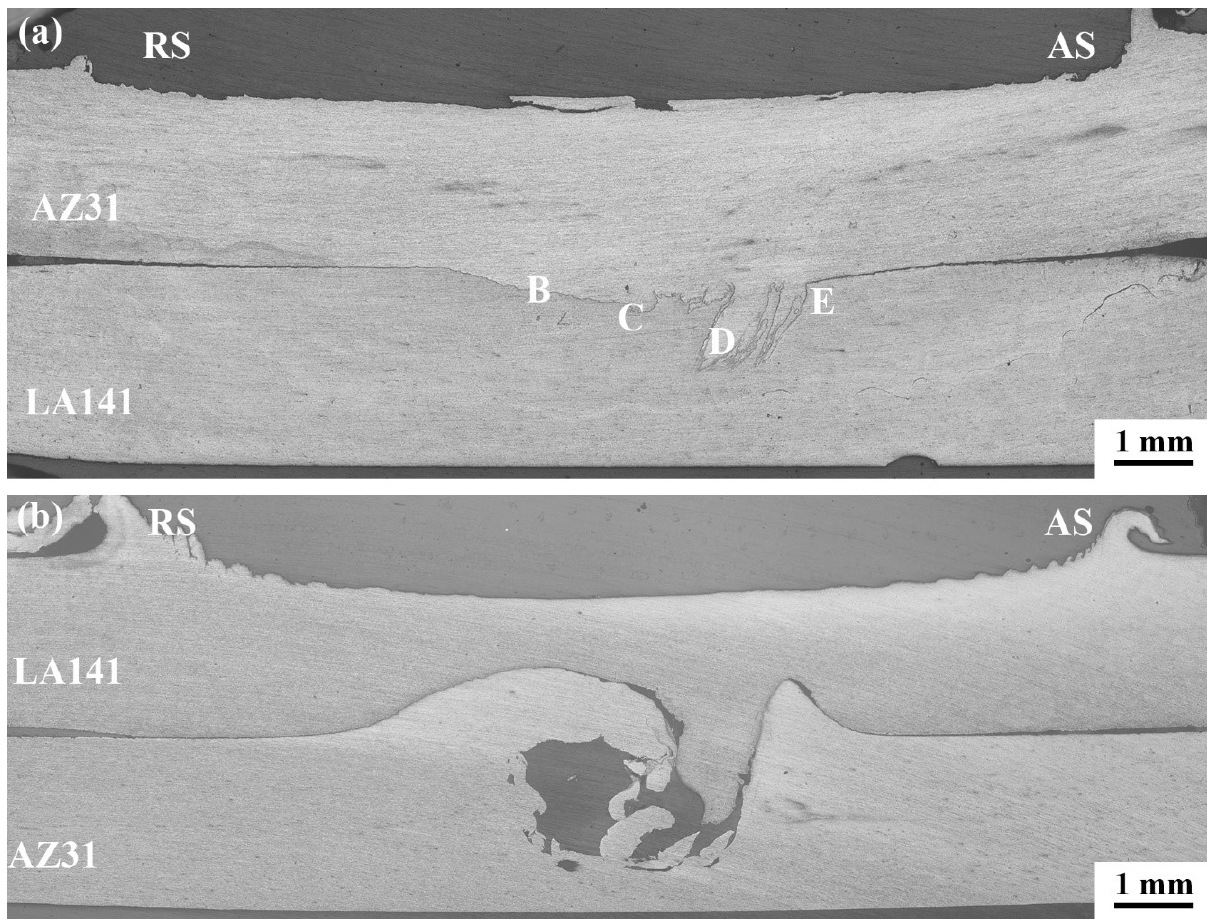
Figure 5: Typical cross-section photographs of FSLW (a) AZ31/LA141 and (b) LA141/AZ31 lap joints.